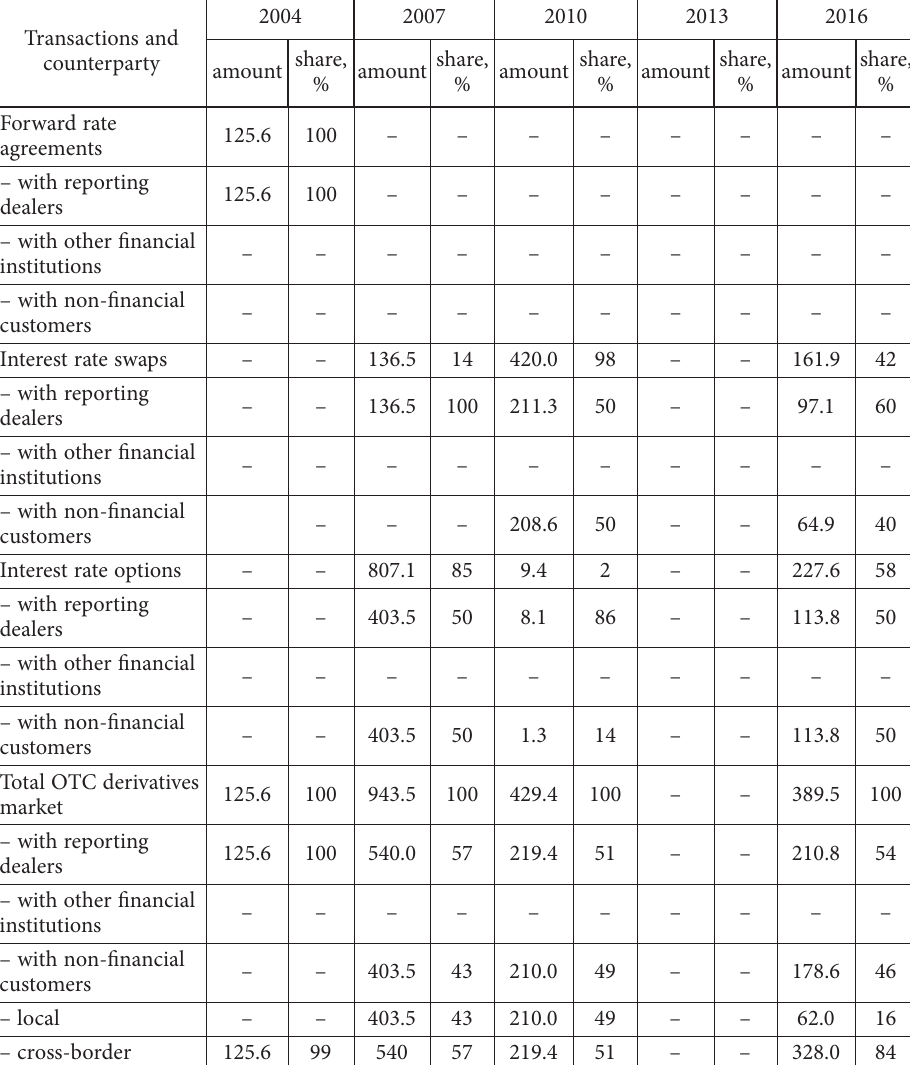
Table 3. Turnover in the Lithuanian OTC derivatives market in 2016 by transactions and counterparty (nominal or notional amounts; millions of U.S. dollars) (source: LB, 2016, 2018; BIS, 2018a,